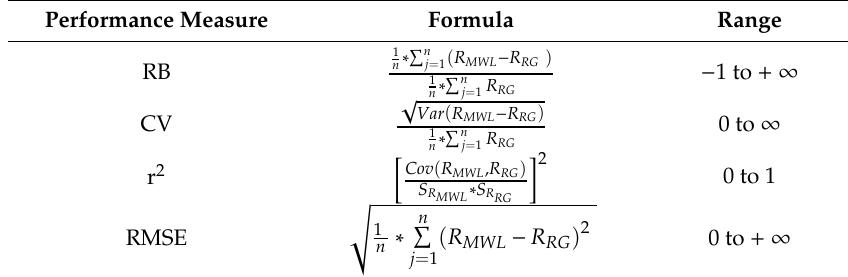
Table 3. Performance measures for evaluating R MWL . Full name of each measure is indicated in the text. j and n represent all timestamps for the evaluation period. Performance Measure